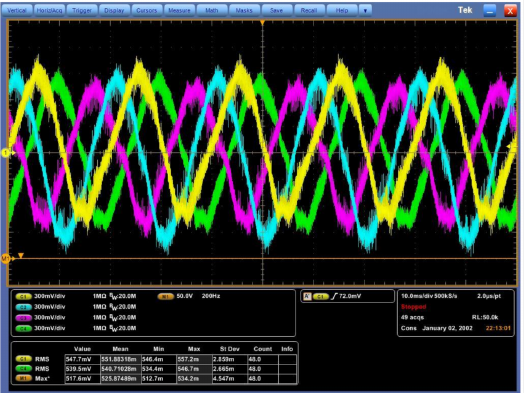
Figure 36. Measured motor phase currents in star connection, no load condition.